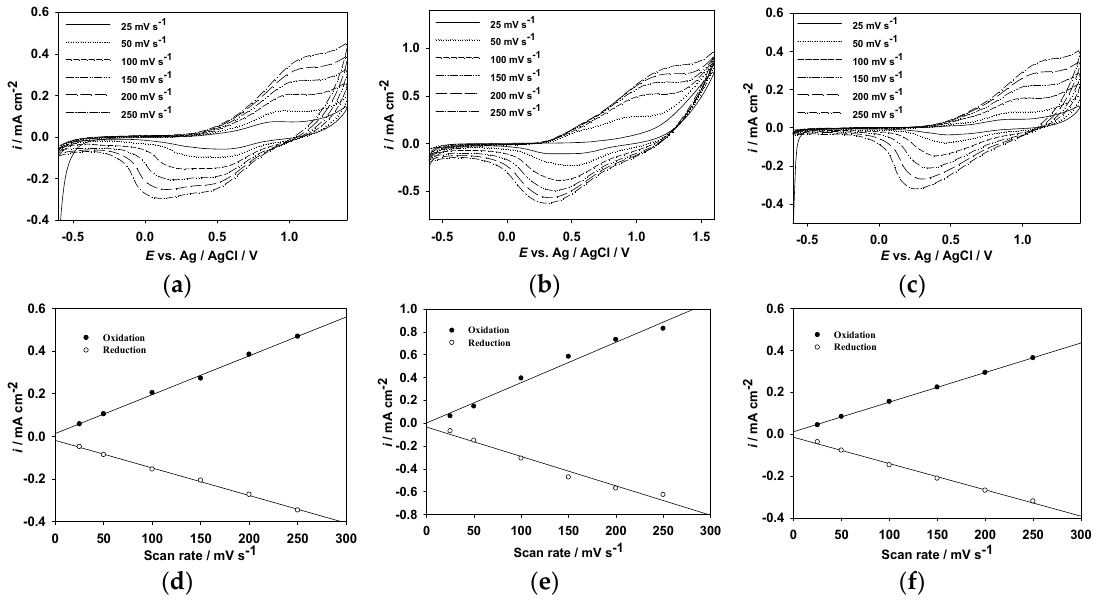
Figure 4. CV curves of ( a ) P(MPS- co -TTPA); ( b ) P(MPO- co -TTPA); and ( c ) P(ANIL- co -TTPA) films at various scan rates between 25 and 250 mV s − 1 in 0.1 M LiClO 4 /ACN solution. Their corresponding relationships of peak current density vs. scan rate of ( d ) P(MPS- co -TTPA); ( e ) P(MPO- co -TTPA); and ( f ) P(ANIL- co -TTPA) films in 0.1 M LiClO 4 /ACN solution.